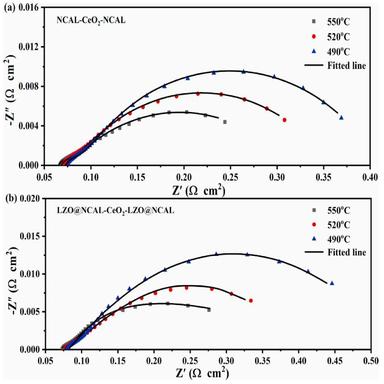
Electrochemical impedance spectroscopy (EIS) results for three cells at (a) NCAL/CeO2/NCAL, (b) LZO@NCAL/CeO2/LZO@NCAL tested at different temperatures in H2 atmosphere.